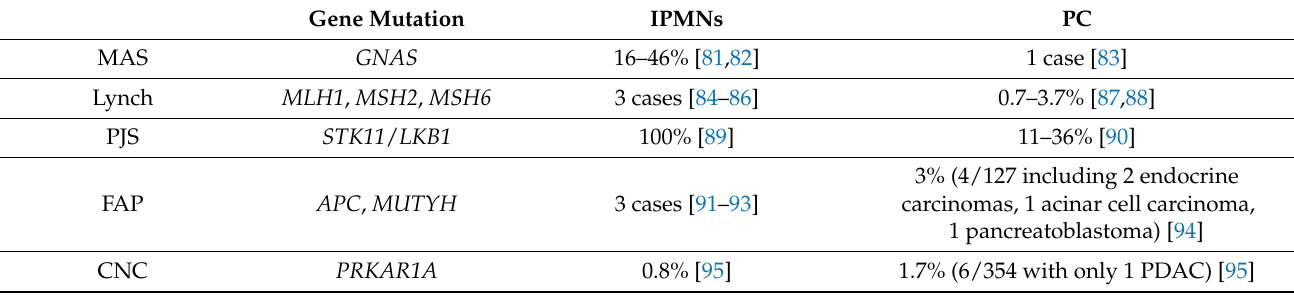
Table 5. Prevalence/incidence of IPMNs and pancreatic cancer in hereditary genetic predisposition